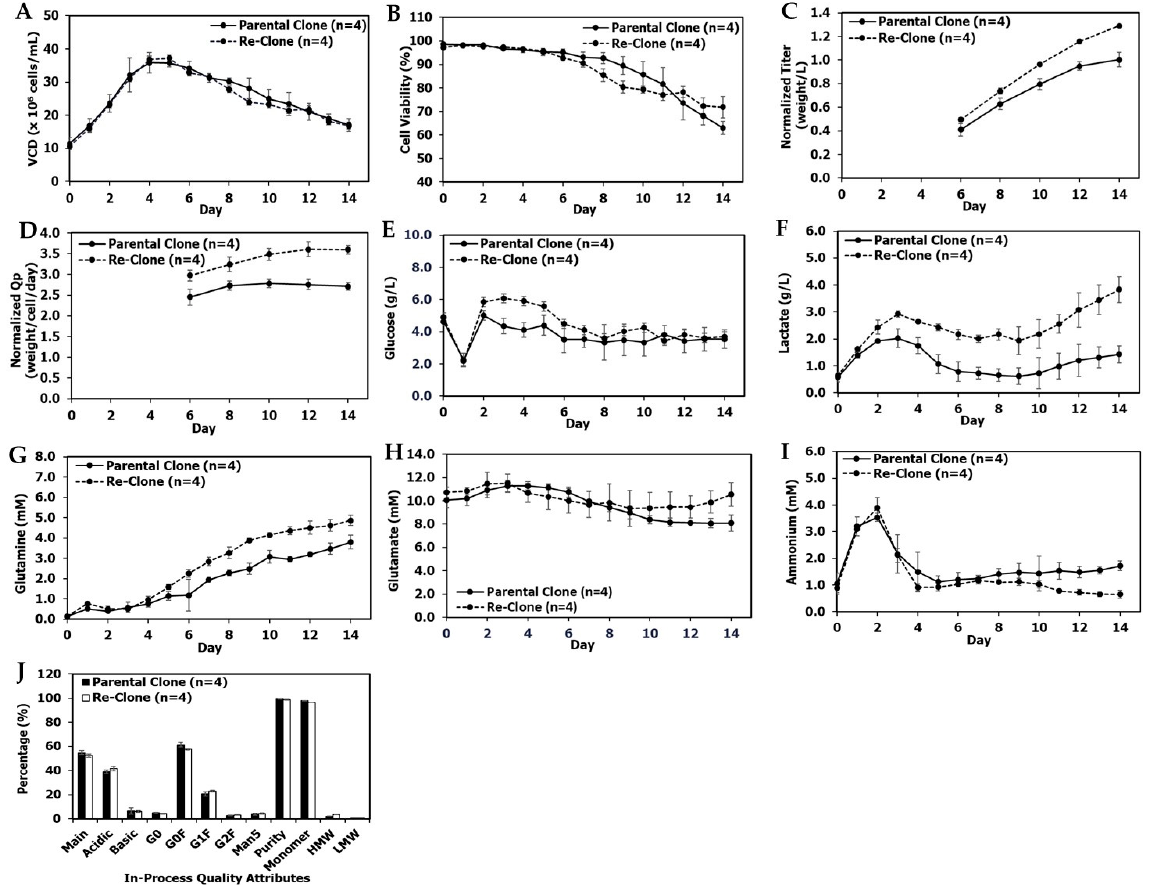
Figure 7. mAb2 production 5L bioreactor culture performance, metabolite and quality attribute profiles between the parental and re-clone. ( A ) Production 5-L bioreactor VCD, ( B ) production viability, ( C ) normalized titer, ( D ) normalized Qp, ( E ) production glucose profiles, ( F ) production lactate profiles, ( G ) production glutamine profiles, ( H ) production glutamate profiles, ( I ) production ammonium profiles, ( J ) in-process quality attribute profiles on day 14 at harvest. The parental clone day 14 titer was normalized as 1. The values are reported as average ± standard deviation (n = 4).